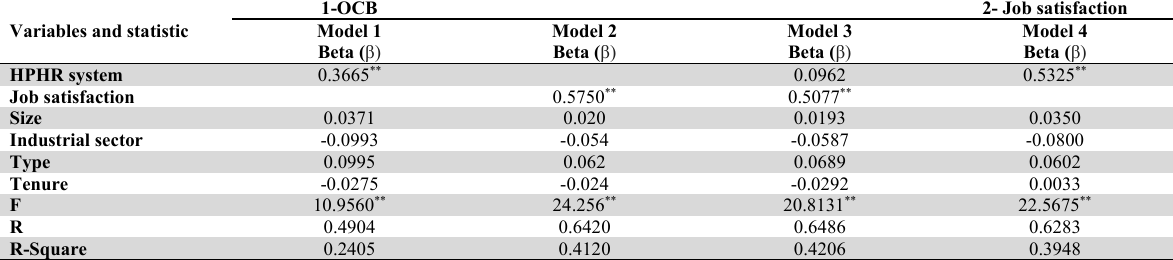
Hierarchical Multiple Regression results for testing mediation 1-OCB 2- Job satisfaction Variables and